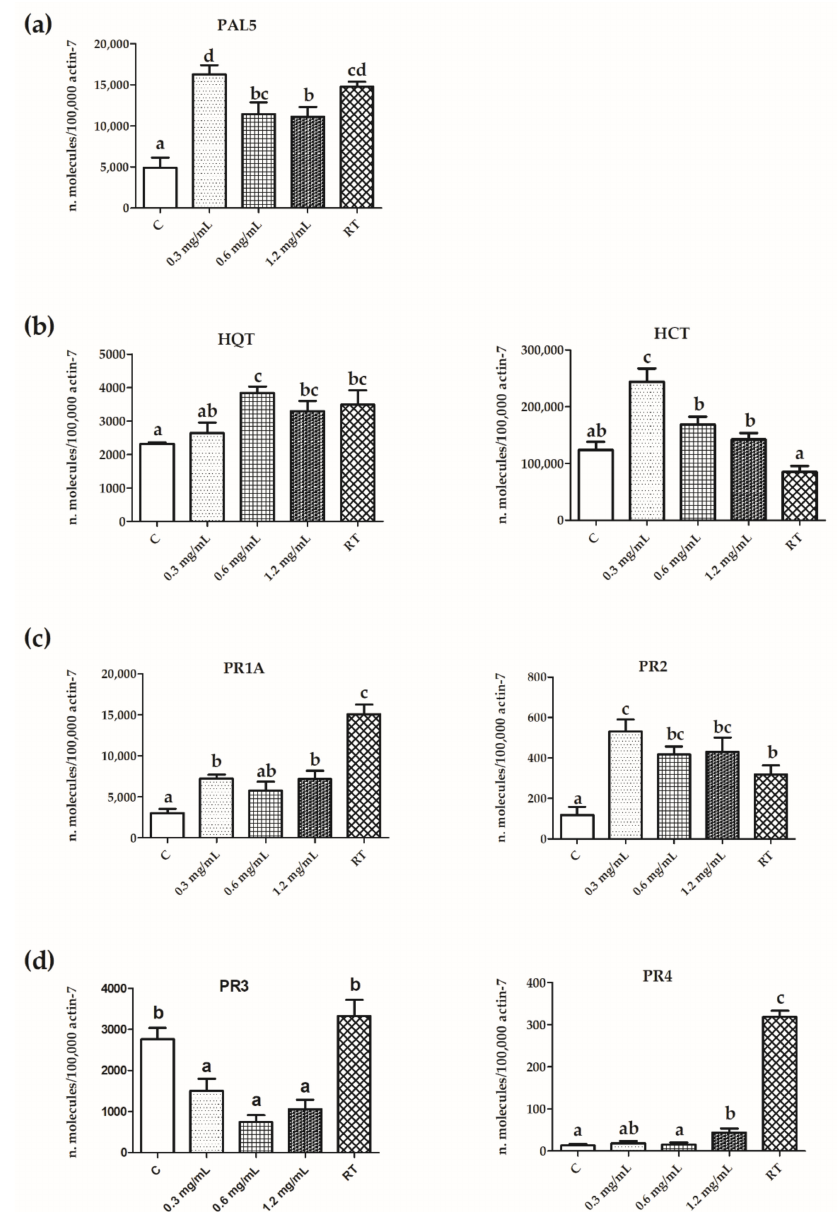
Figure 7. Transcriptional expression levels of phenylpropanoid ( a ), chlorogenic acid ( b ), systemic acquired resistance ( c ), and induced systemic resistance ( d ) biosynthetic pathways genes in tomato plants as a response to seed treatment with different concentrations (0.3, 0.6, and 1.2 mg/mL) of Jania adhaerens water-soluble polysaccharides. C = control; RT = reference treatment (2 mL/L); PAL5, phenylalanine ammonia-lyase; HQT, hydroxycinnamoyl CoA quinate hydroxycinnamoyl transferase; HCT, hydroxycinnamoyl CoA shikimate hydroxycinnamoyl transferase; PR1A, PR2, PR3 and PR4, pathogenesis-related genes. Columns are mean values of 3 independent experiments ( n = 3) ± SD. Different letters indicate significant differences among treatments and the control according to the LSD test ( p <